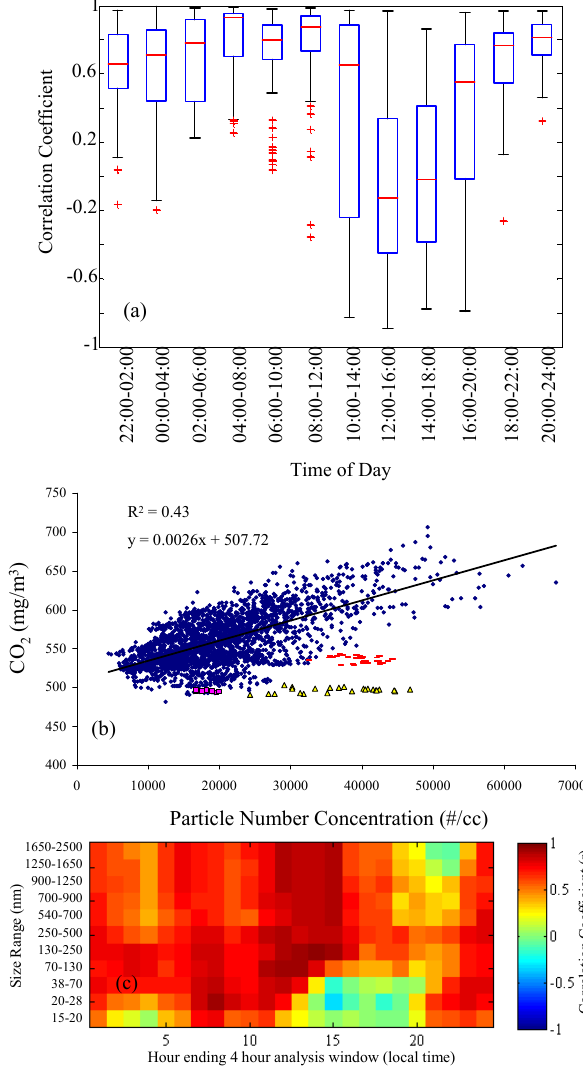
Figure 4. (a) Correlation coefficient of 10-minute averaged CO 2 and total number over 4- Fig. 4. (a) Correlation coefficient of 10-min averaged CO 2 and total hour periods, (b) 10-minute averages of CO 2 concentration versus particle number concentration for the entire period from March 9 to March 29 (squares, triangles and number over 4-h periods, (b) 10-min averages of CO 2 concentration dashed lines highlight measurements obtained during new particle formation events) and versus particle number concentration for the entire period from 9 (c) Correlation coefficient for various size ranges. Local time (x-axis) is the last hour of a 4-hour time window over which correlation with CO 2 is analyzed (e.g. hour 15 shows March to 29 March (squares, triangles and dashed lines highlight correlations from 11:00 until 15:00). measurements obtained during new particle formation events) and (c) correlation coefficient for various size ranges. Local time (x- axis) is the last hour of a 4-h time window over which correlation with CO 2 is analyzed (e.g. hour 15 shows correlations from 11:00 until